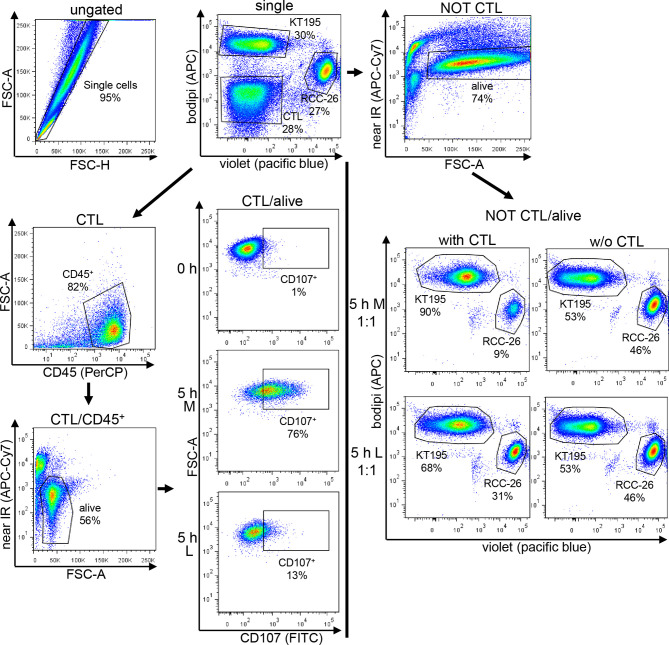
Gating strategy used for the CTL-mediated killing and degranulation. CTL were incubated with target cells (RCC-26, labeled with CellTracker-Violet) and non-target cells (KT195, labeled with Bodipi) for 5 h at a ratio of 1:1:1 in Medium (M) or 20 mM lactic acid medium (L). In parallel, tumor cells were cultured without CTL. After 5 h, cell suspensions were harvested and stained with anti-CD45-PeCy7 to detect the CTL and near-IR-fluorescent-reactive dye for live/dead discrimination. Data acquisition employed LSRII cytometer and data were analyzed using FlowJo. After initial single cell selection, target cells (RCC-26) and non-target cells (KT195) were discriminated in CT-Violet/Bodipi dot plots. CTL were identified as being neither positive for CT-Violet nor Bodipi. From the CT-Violet/Bodipi dot plot, the specific killing of target RCC-26 was calculated by determining the shift in the ratio of target cells (violet+) to non-target cells (bodipi+) in the NOT CTL/ normal script alive population in the presence and absence of CTL (see equation for calculation in Material/Methods). CTL degranulation was evaluated in the CTL/alive population by analyzing the percentage of CD107+ CTL in the CD45+ population as compared to the unstimulated (0 h) CTL.